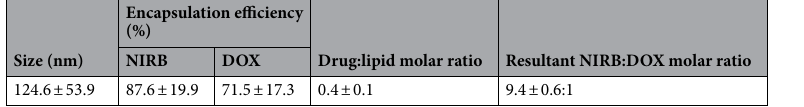
Table 2. Size, encapsulation efficiency, and drug to lipid ratio of the optimized, folate conjugated, lead liposome candidate, NIRB-DOX-FA. Nanoparticle size was determined by DLS. NIRB and DOX concentrations were determined by HPLC–UV analysis and lipid quantification was performed by HPLC-